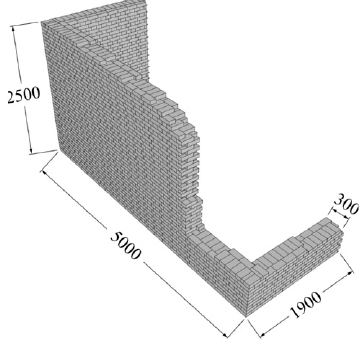
Figure 2. ( a ) A general view of Isabey Mosque and ( b ) the inside view of the West courtyard wall [38].